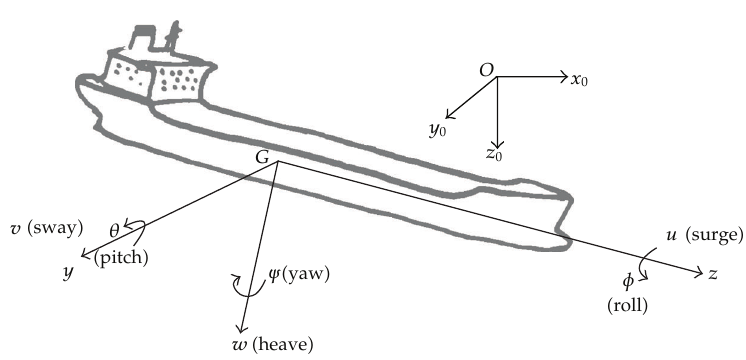
Figure 7: Body-fixed and earth-fixed references